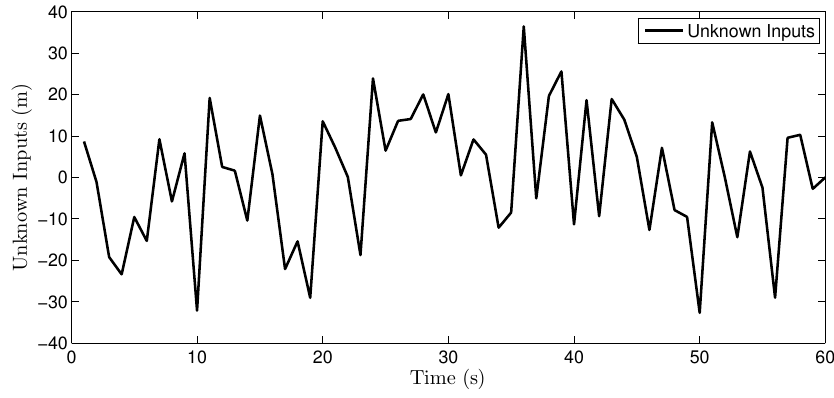
Figure 12. Real unknown input in the multi-sensor system of 60 sensors.